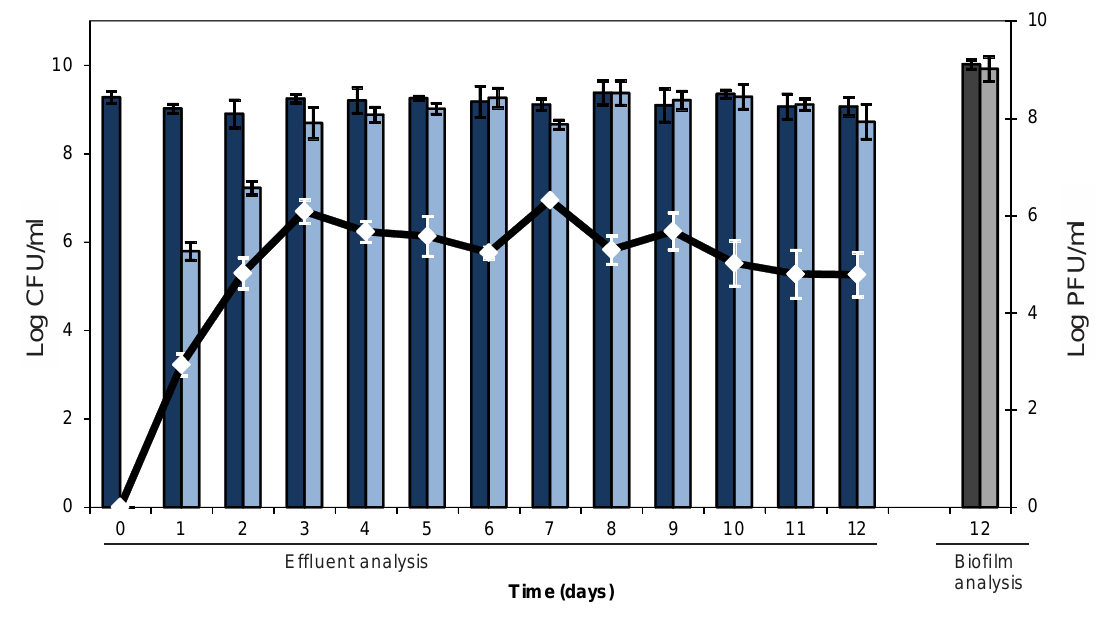
Figure 1. Numbers of viable cells (CFU/mL) and phages (PFU/mL) in the effluent of a mature E. coli biofilm exposed for 1 hour to 50 PFU/mL (total of 150 PFU per biofilm) of H-19B::Tn10 phage at day 0, after sampling the effluent for initial total cell count. Dark blue bars represent total cell concentration, while light blue bars represent the concentration of H-19B::Tn10 lysogens. White markers represent free H-19B::Tn10 phage. Dark and light grey bars represent total cell counts and lysogen cell counts, respectively, in the attached biofilm obtained after dismantling the flow cell setup. The data represent the average and standard deviations of three biological